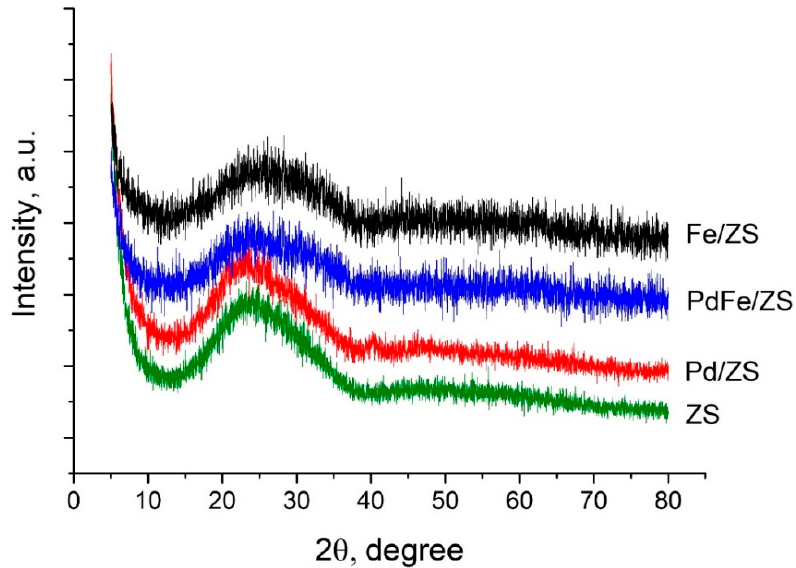
Figure 3. XRD profiles of ZS support and catalysts reduced in H 2 flow for 2 h at 320 °C (Pd/ZS and FePd/ZS) or 520 °C (Fe/ZS). FePd/ZS) or 520 ◦ C